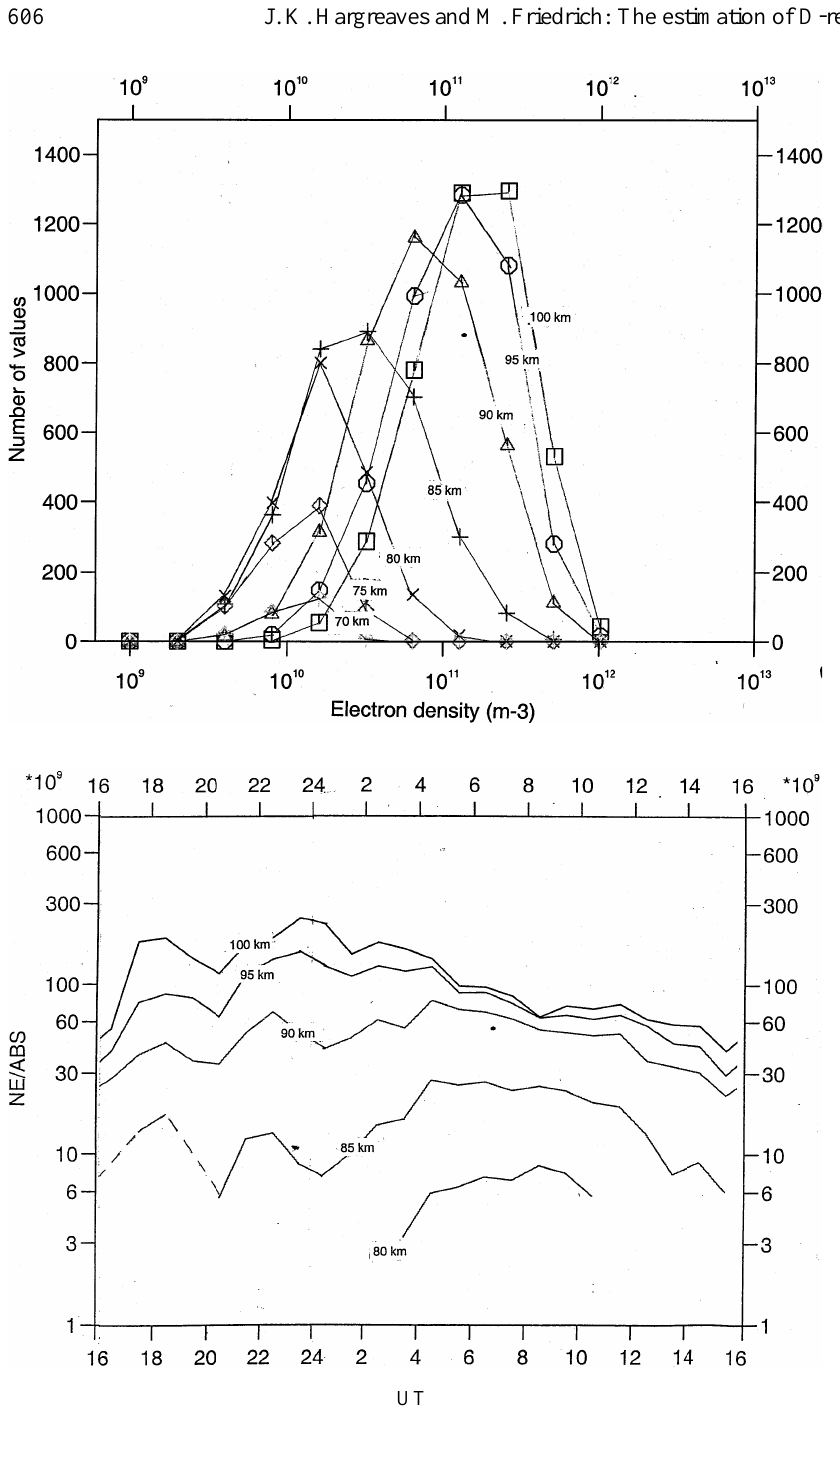
Fig. 4. Medians for whole data set, 1985–1992. Variation of median elec- tron density (for 1dB absorption) with time of day. At EISCAT local mag- netic midnight is about 21:30UT. The data show a daily cycle starting about six hours before magnetic